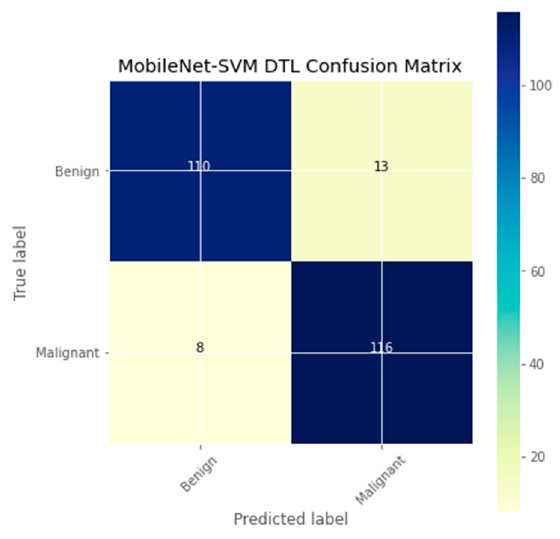
Figure 8. Confusion matrix of the MobileNet-SVM model.